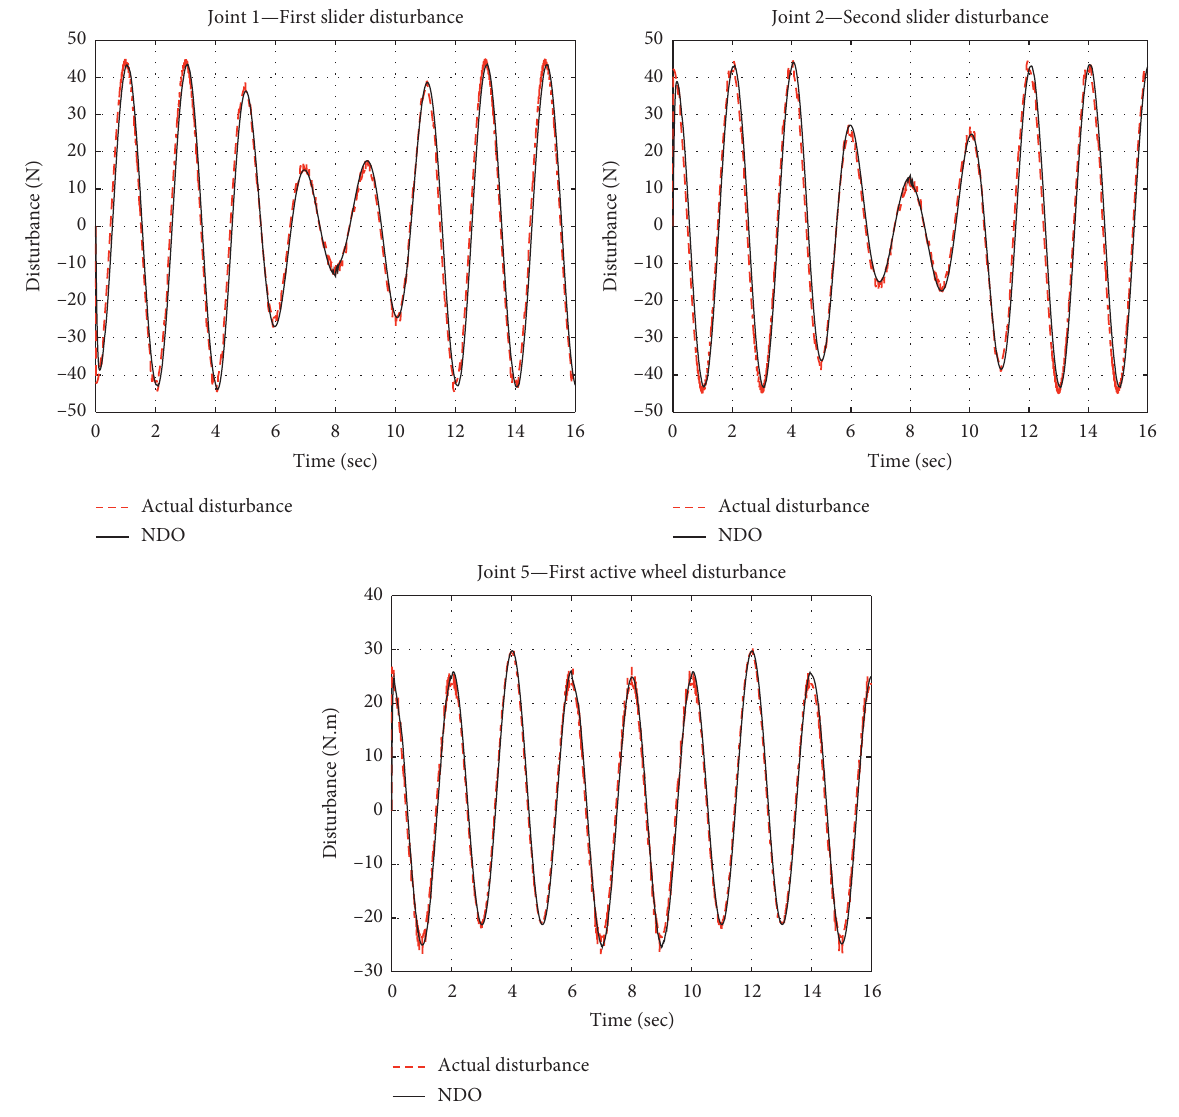
Figure 6: Estimated disturbances for each